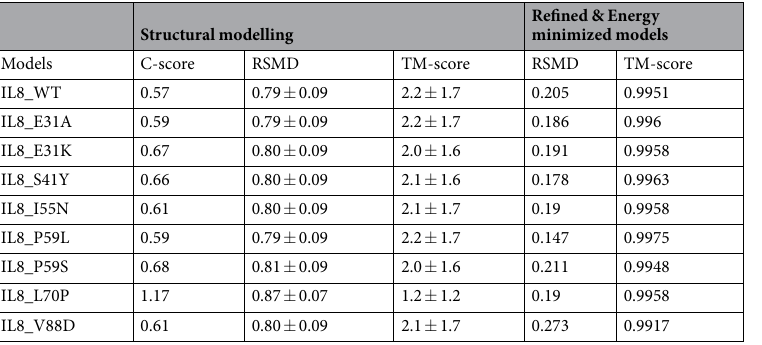
Table 7. Statistical outputs of the modeled 3D structure of different mutant IL-8 protein using I-Tasser (left side). I-TASSER predicted 3D models of mutant IL-8 proteins after structural refinement and energy minimization with ModRefiner (right